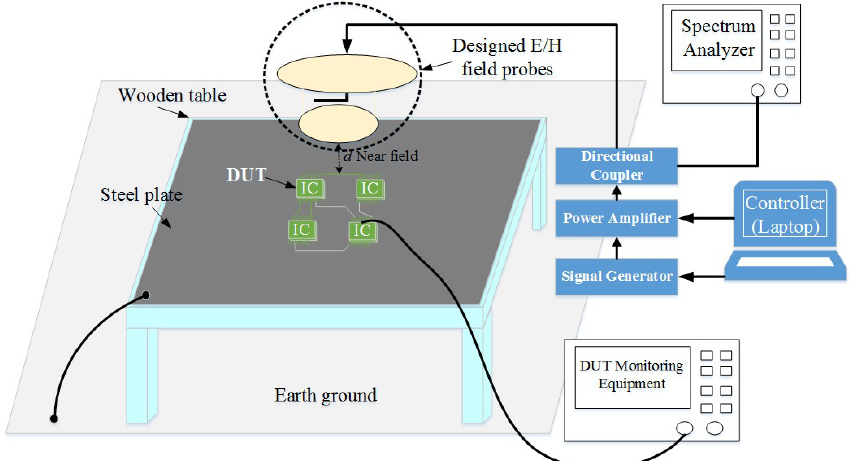
Figure 2. Proposed near-field immunity test (NFIT) setup for fast radiated immunity debugging of